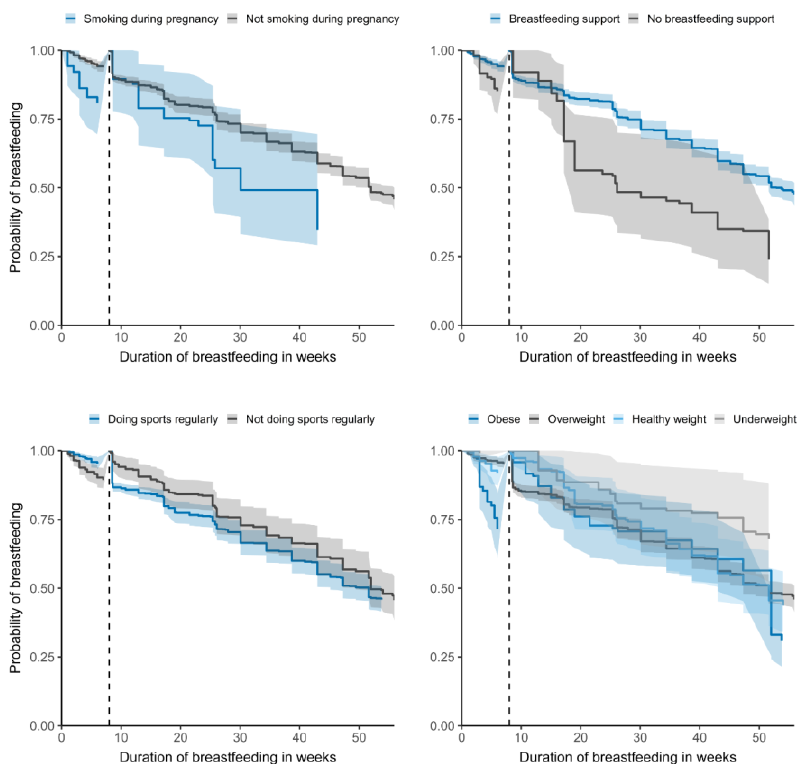
Figure 1. Kaplan – Meier survival curves for influencing factors on breastfeeding duration ( n = 822). Table 3. Cox regression of factors influencing shorter breastfeeding duration considered separately for 2 different age ranges of infants ( n =